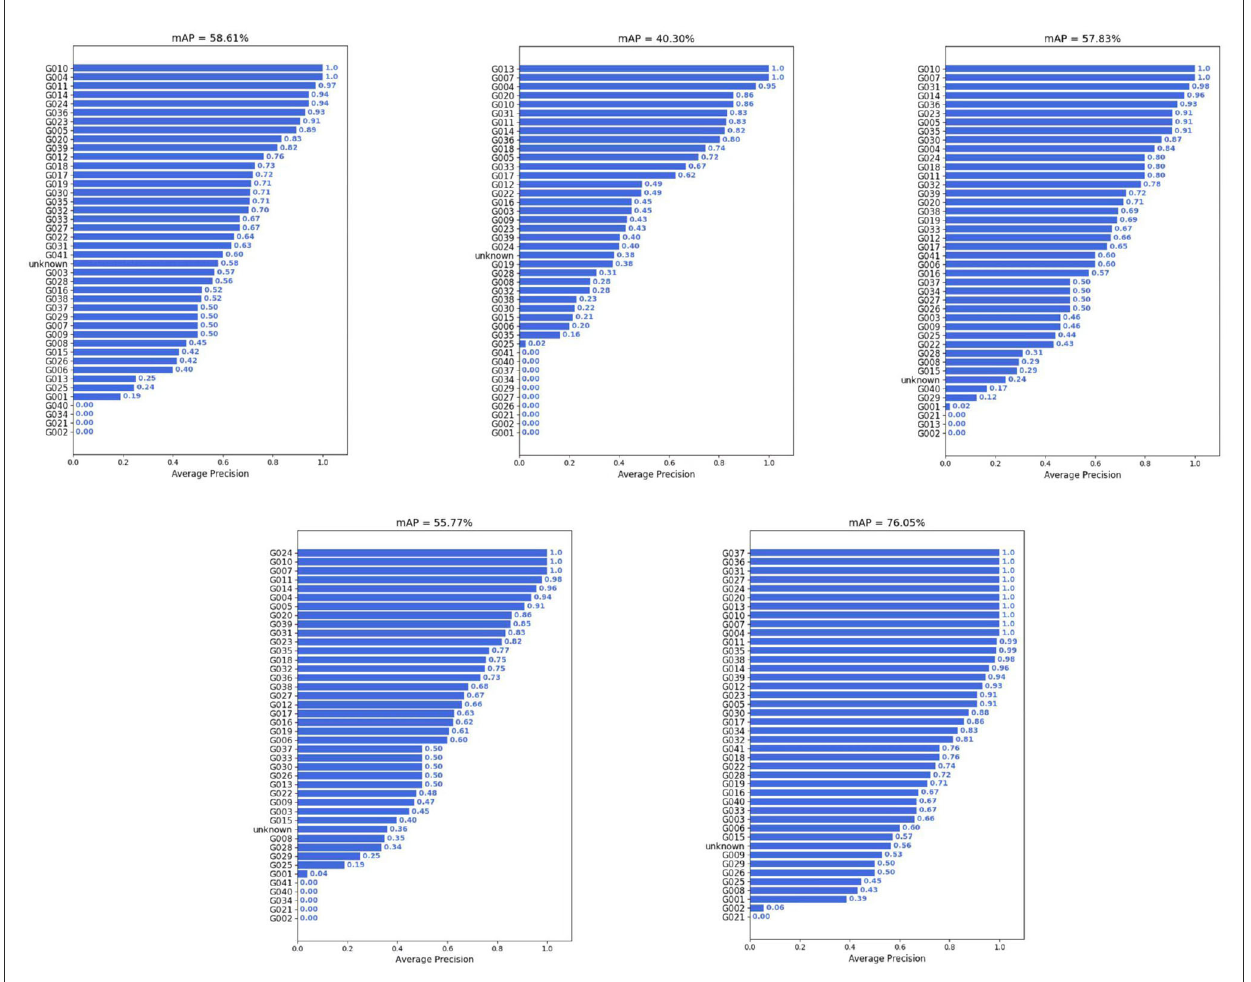
FIGURE3 Each category of EM object detection prediction AP value in